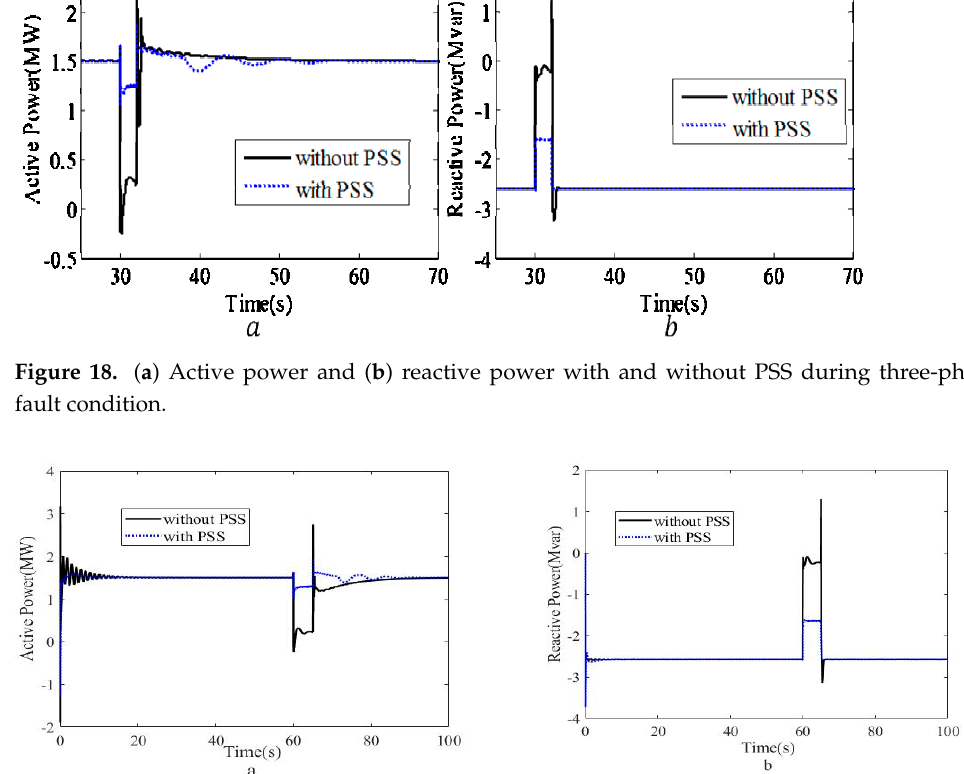
Figure 19. ( a ) Active power and ( b ) reactive power with and without PSS during single-phase short circuit fault condition.